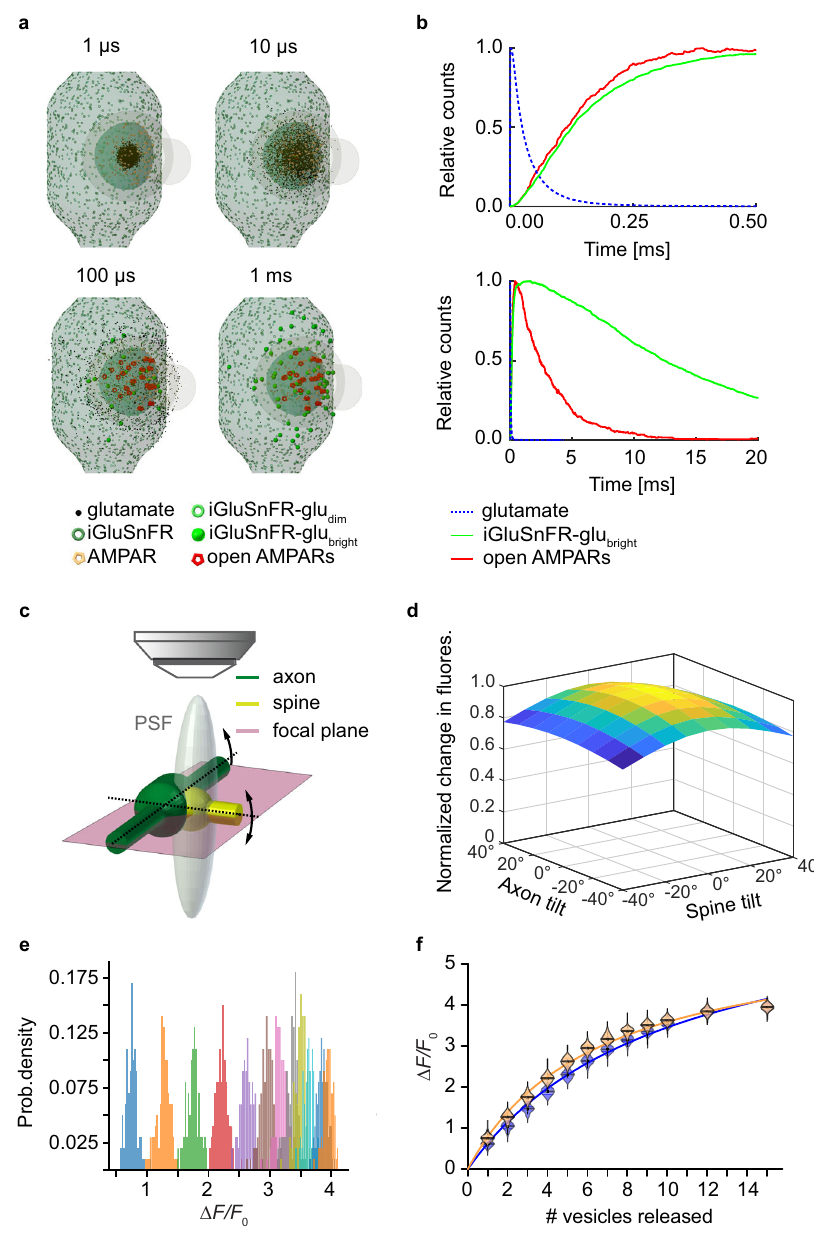
Fig. 5 | Monte-Carlo-simulation of glutamate diffusion in the synaptic cleft. a Simulatedglutamatedynamicsafterreleaseofasinglevesicle.Themodelconsists ofapresynapticterminalwithiGluSnFRmoleculesopposedtoaspinewithAMPARs randomlydistributed ina discof300nm, separatedby a20-nm synaptic cleft. The synapse is embedded in a network of astrocytes equipped with glutamate trans- porters (not shown). b Kinetics of AMPAR opening and iGluSnFR entering the bright fl uorescentstateuponreleaseofasinglevesiclecontaining3000molecules of glutamate (upper panel) and expanded time scale (lower panel). c Model geo- metry including the point spread function (PSF) of the microscope. Different